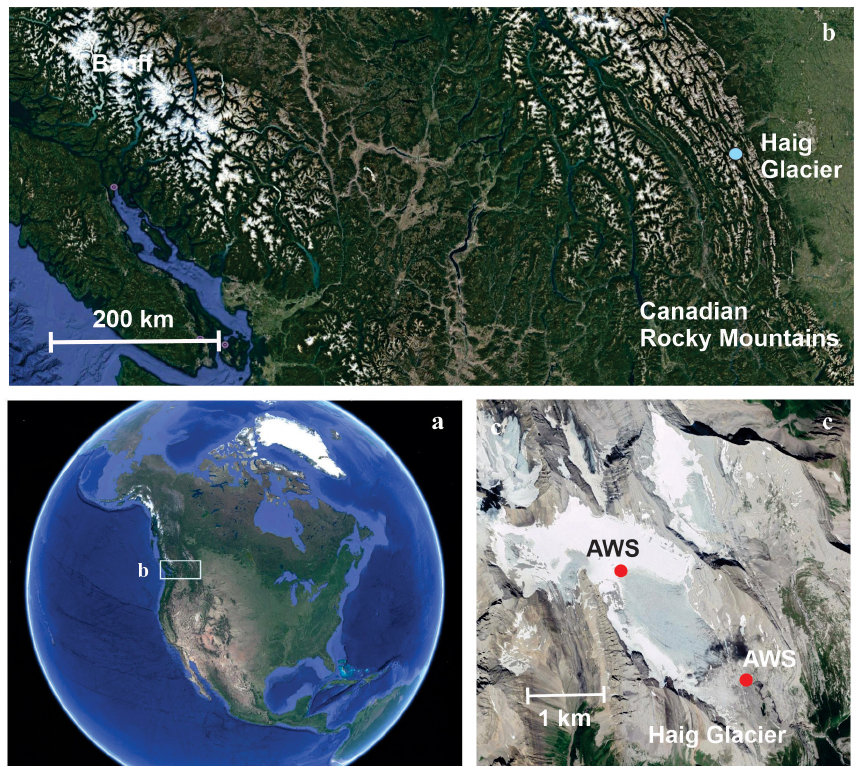
Figure 1. (a) Haig Glacier study area in southwestern Canada (see b ). (b) Haig Glacier is about 100km southwest of Calgary, AB, on the eastern slopes of the Canadian Rocky Mountains. (c) Map view of the glacier, indicating the locations of the two automatic weather stations (AWSs). All images are courtesy of © Google Earth. Table 1. Mean summer albedo and mass balance conditions at Haig Glacier, 2002–2017, based on glacier-wide simulations driven by local AWS data. B w , B s , and B n are the winter, summer, and annual specific mass balance; N m and N ss are the number of melt days and summer snowfall days from May through September; PDDs are the positive degree days over the summer melt season, T and Q N are the mean June through August (JJA) air temperature and net energy flux; and E m is the total summer melt energy. Albedo values are measured at the glacier AWS: α S is the mean JJA surface albedo, and α i is the measured ice albedo for the composite of snow-free days ( N = 224). B w B s B n